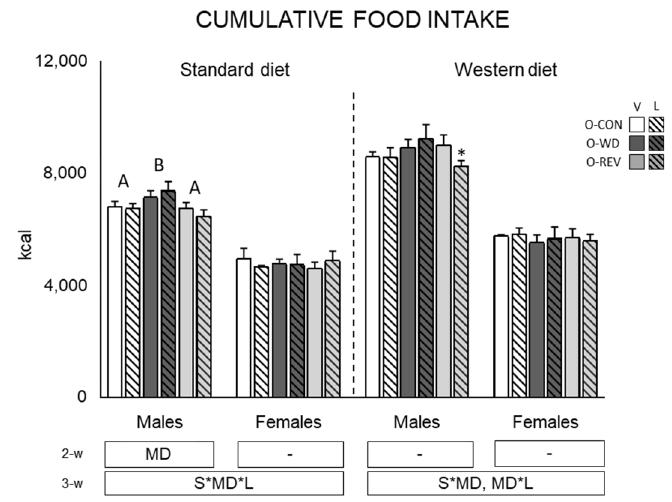
Figure 3. Cumulative food intake from one to four months of age of O-CON, O-WD and O-REV male and female animals treated with vehicle or leptin during suckling and fed SD or WD from weaning. Data are mean ± SEM ( n = 8–12). Statistics: After data separation depending on post-weaning diet, three-way ANOVA was performed to analyze the effect of sex, maternal diet and/or leptin treatment. In each sex, two-way ANOVA was performed to analyze the effect of leptin treatment and/or maternal diet. Single comparisons between leptin versus vehicle-treated rats of all experimental groups were carried out using Mann-Whitney U test. Symbols: sex (S), maternal diet (MD), leptin treatment (L); A (cid:54) = B ( p < 0.05, LSD post-hoc, two-way ANOVA); *, different from their vehicle-treated equal ( p < 0.05, Mann-Whitney U test). Abbreviations: offspring of CON-dams (O-CON), offspring